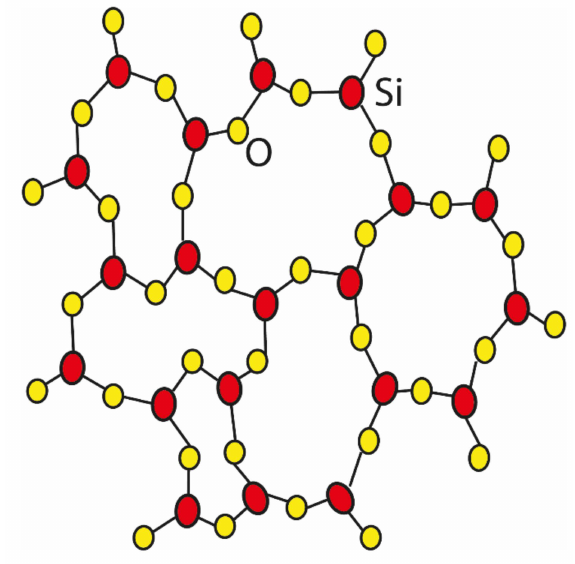
Figure 1. The ball-and-stick diagram of the structure of amorphous silica (adapted from Keen and Dove